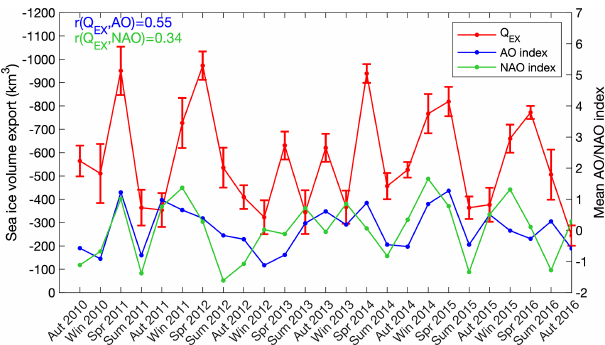
Figure 13. CMST interannual Arctic sea ice volume export (unit: km 3 ) through the entire Fram Strait with corresponding uncertainty. The freezing season represents the months from October to April, and the melt season is from May to